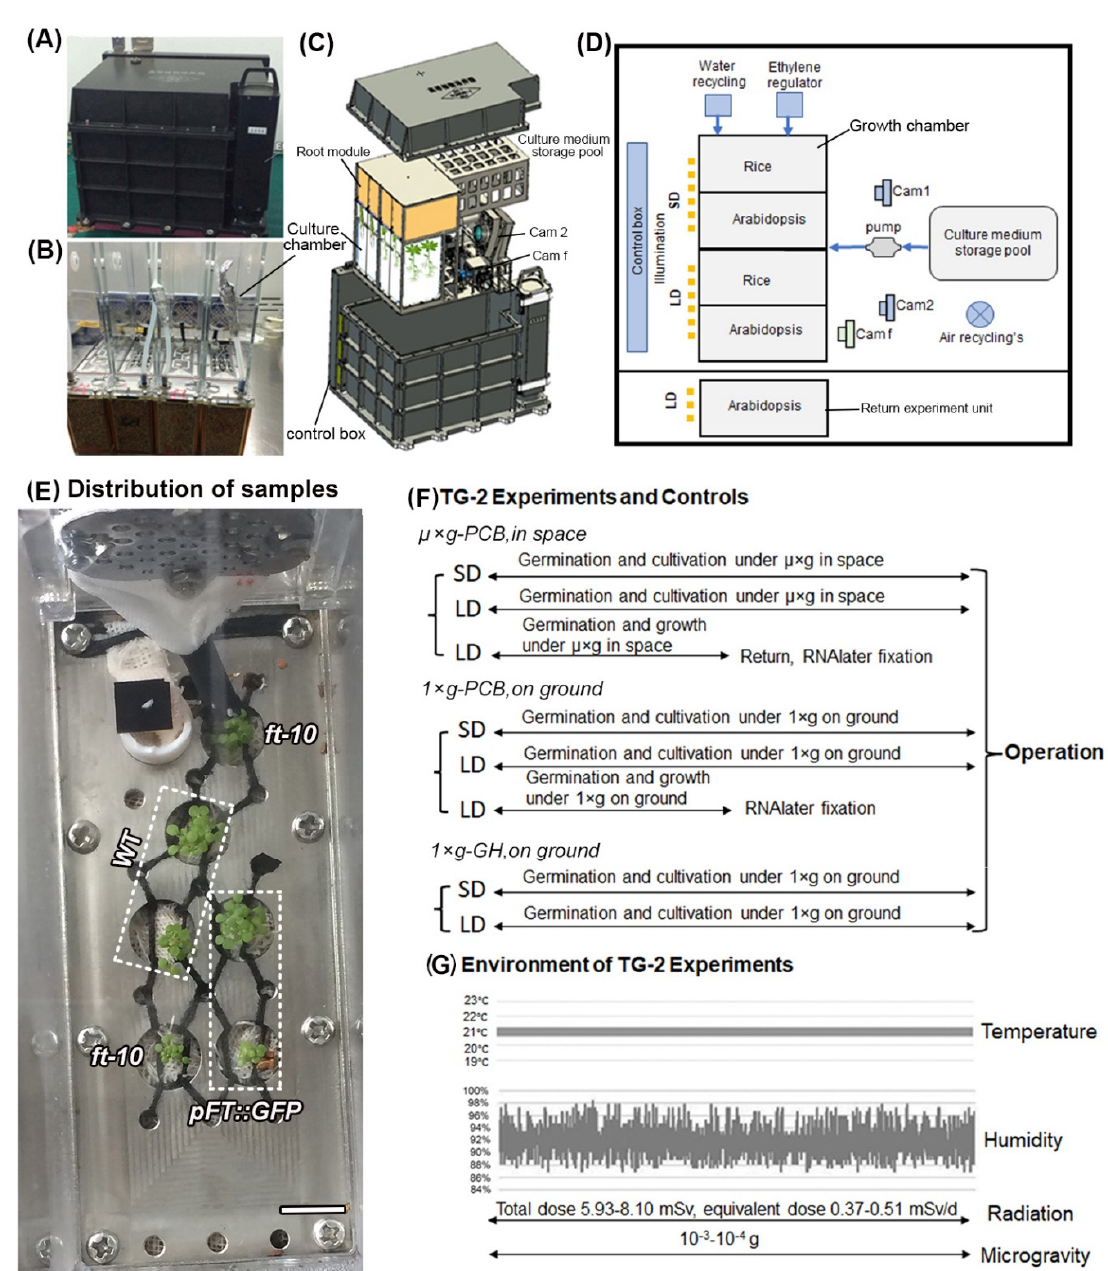
Figure 1. The plant culture box (PCB) on board the Chinese spacelab TG-2 and experimental design. ( A ) The outside view of the PCB, the dimensions are 300 × 300 × 400 mm 3 . ( B ) Culture chambers. ( C ) The assembly of the inside view of the PCB with cover, showing growth chamber, culture medium pool, and three digital cameras. ( D ) Diagram of the composition inside the PCB, showing water recycling, ethylene regulator, nutrient delivery, illumination system, image acquirement subsystem including two cameras for acquisitioning visible images (Cam 1 and Cam 2) and one camera for fluorescence images acquisition (Cam f). ( E ) An example image to show distribution of samples on the installation panel of culture chambers. Scale bar = 10 mm. ( F ) Schematic representation of the scenarios used in space experiments in PCB under microgravity on board the Chinese spacelab TG-2 (µ× g -PCB) and their corresponding controls at the 1× g gravity condition on the ground in PCB (1× g -PCB) or in a greenhouse (1× g -GH). The experiments comprised two photoperiod conditions: Long-day (LD, 16 h light/8h dark) and short-day (SD, 8 h light/16h dark). ( G ) Temperature, humidity, radiation, and microgravity conditions are indicated for each experiment.